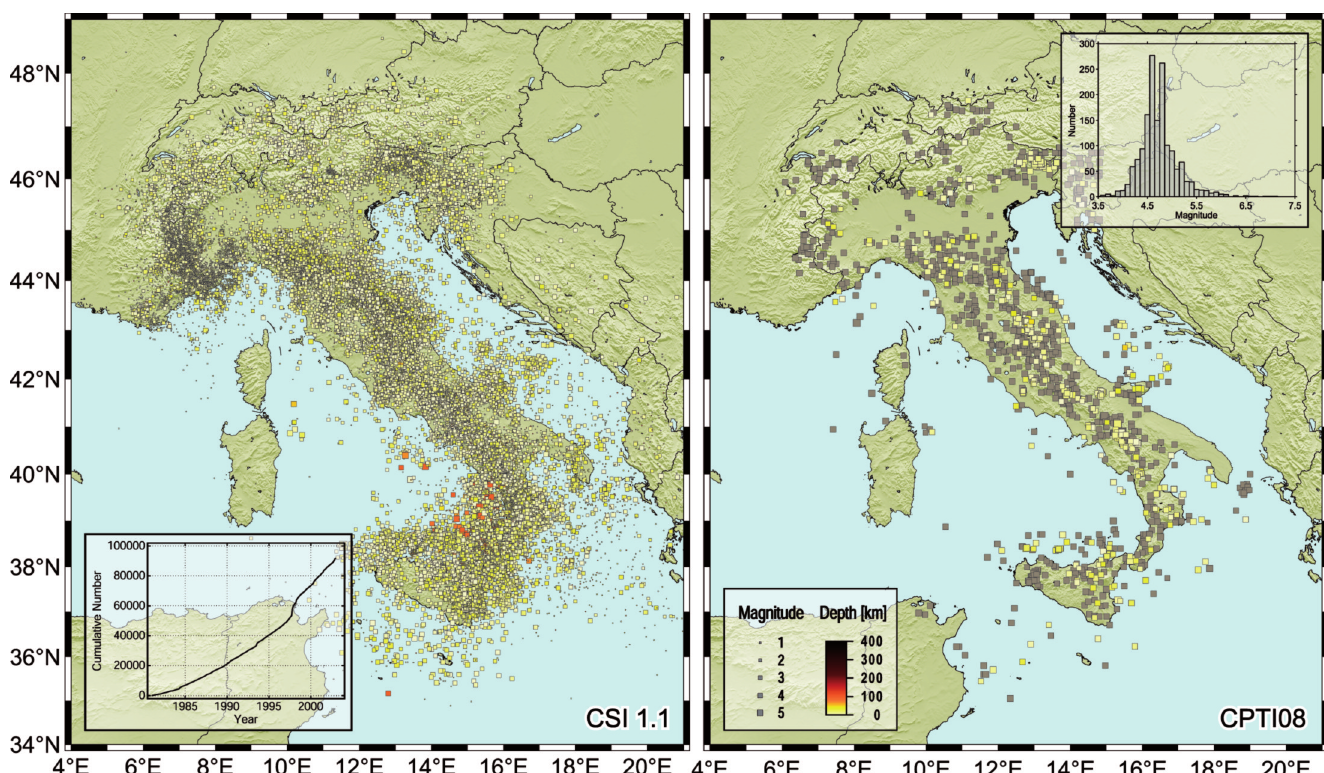
Figure 4. (Left) Map of earthquakes in the CSI 1.1. The inset shows the cumulative number of events over time in the CSI 1.1. (Right) Map of earthquakes in the CPTI08 catalog. Events without depth information are plotted in brown. The inset shows the histograms of 1579 macroseismic moment magnitudes ≥ from the CPTI08 with M w